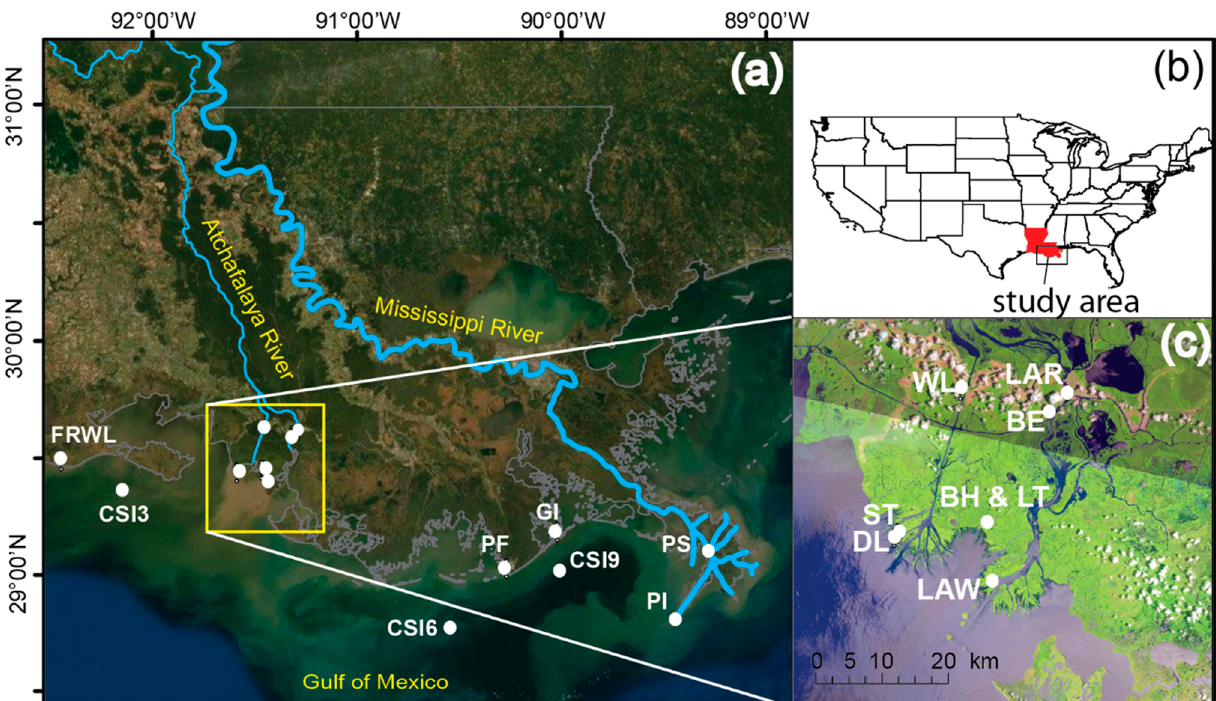
Figure 1. Map of the study region and field sites. ( a ) The Louisiana coast and observational stations in the northern GOM. NOAA, WAVCIS, field ADCP, and USGS stations. BH: Big Hog Bayou; DL: Delta #1; LAW: LAWMA; BE: Berwick; FRWL: Freshwater Canal Locks; GI: Grand Isle; PS: Pilot’s Station East, SW Pass; PI: Pilottown; PF: Port Fourchon; ST: Small Tripod; LT: large tripod; WL: Wax Lake Outlet at Calumet; and LAR: Lower Atchafalaya River at Morgan City. ( b ) Inset showing the study region. ( c ) Zoomed-in view of the box in ( a ) detailing the stations in the Wax Lake region. The latitude and longitude for each station are listed in Table 1.